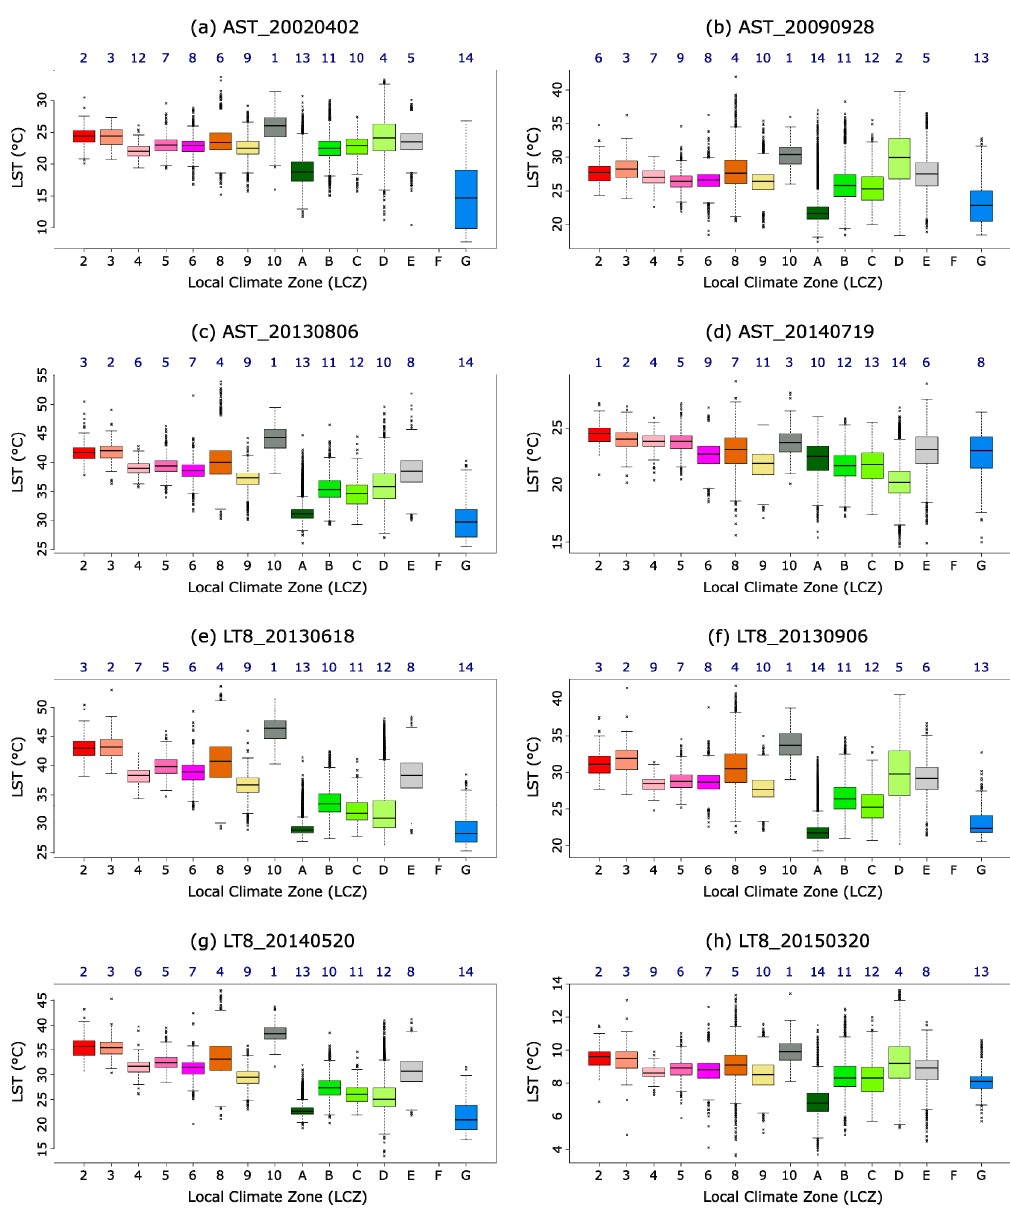
Figure 6. Box-plots with LSTs in LCZ classes in Brno for ASTER ( a – d ) and LANDSAT-8 ( e – h ) images; see Table 3 for the scene ID; the line within the box indicates median. The bottom of the box is the first quartile, and the top is the third quartile. Whiskers represent the lowest value still within 1.5 IQR (IQR = third quartile − first quartile) and the highest value still within 1.5 IQR. Black crosses indicate outliers. The top row with blue numbers indicates the order of LCZ according to the average LST (1, the warmest zone; 14, the coldest zone).